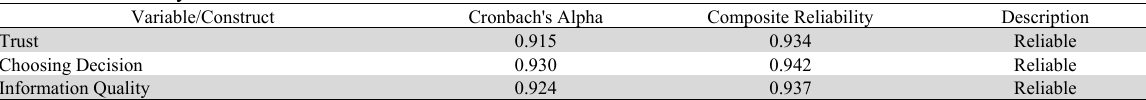
Result of Reliability